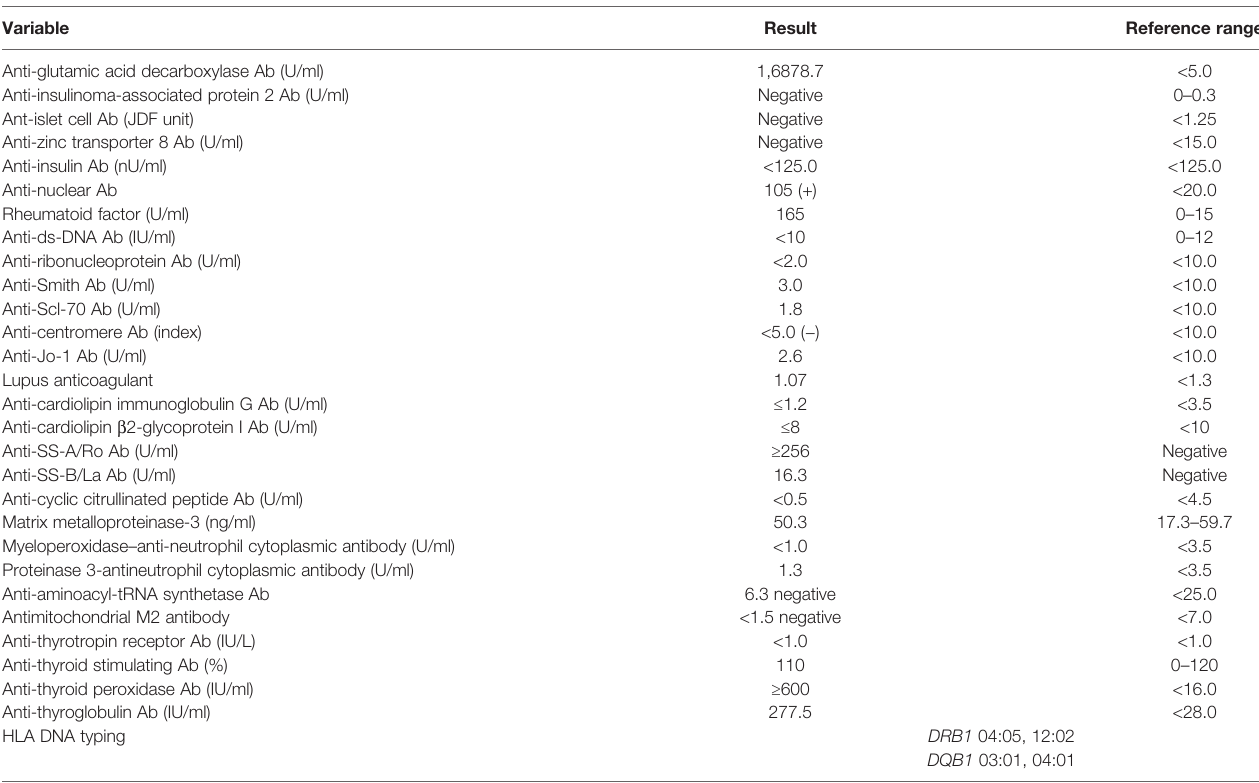
TABLE 2 | Disease-speci fi c antibodies and HLA DNA typing in this subject.